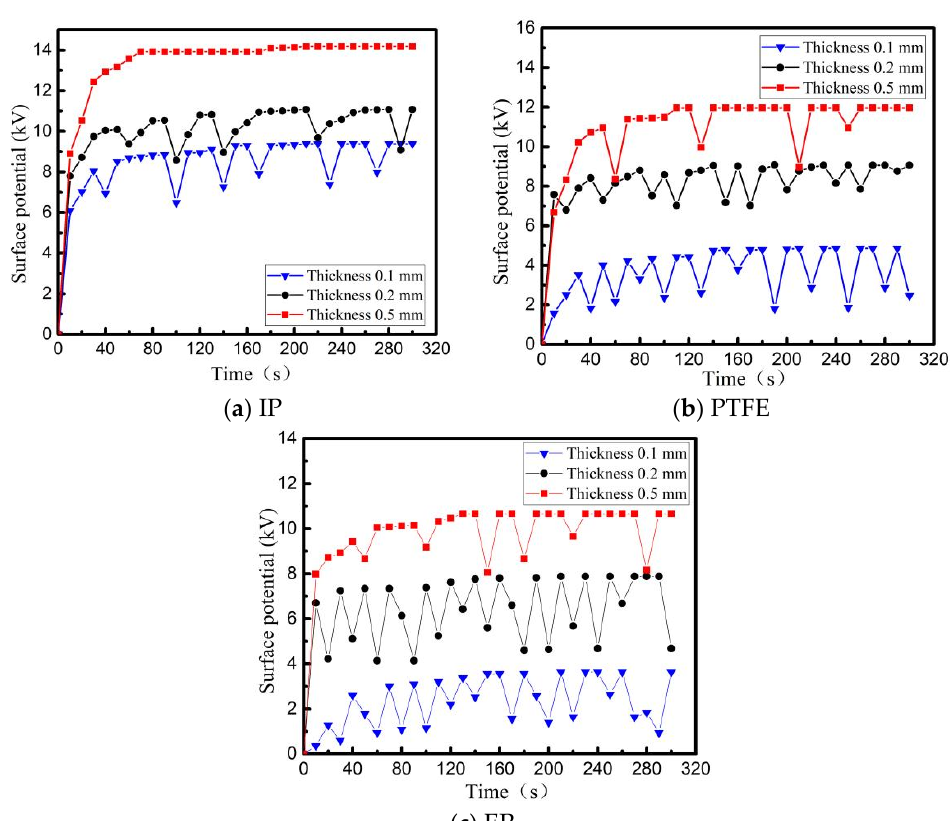
Figure 10. Surface potential of dielectric surface with different thickness irradiated by ESD field ( a ) PTFE, ( b ) PI, ( c ) EP .